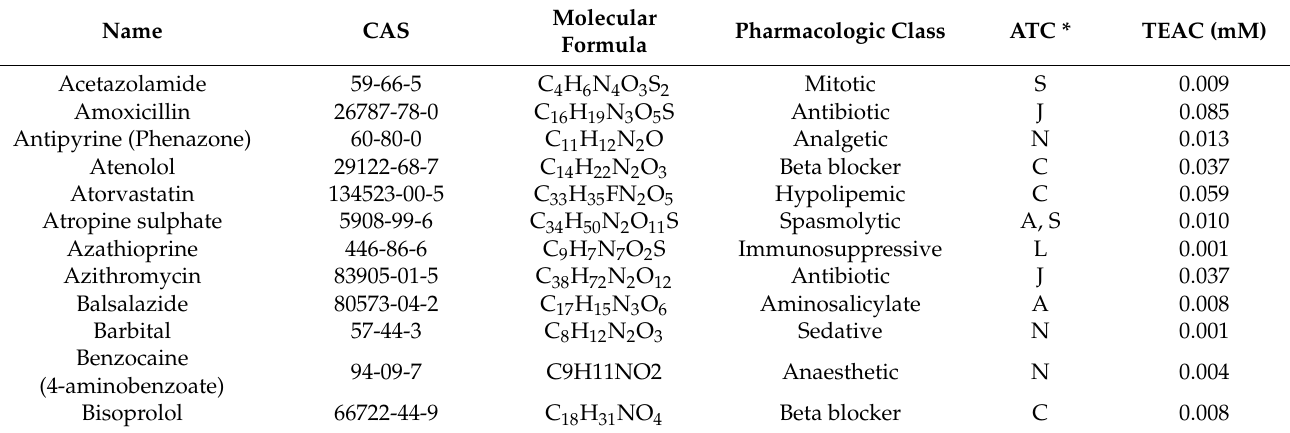
Table 1. Description of investigated